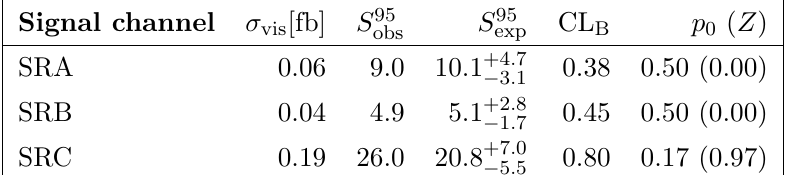
Table 7. From left to right, observed 95% CL upper limits on the visible cross sections (cid:27) observed ( S 95 ) and expected ( S 95 ) 95% CL upper limits on the number of signal events with (cid:6) exp obs 1 (cid:27) excursions of the expectation, the CL of the background-only hypothesis, CL B , the discovery p -value ( p 0 ), truncated at 0.5, and the associated signi(cid:12)cance (in parentheses).